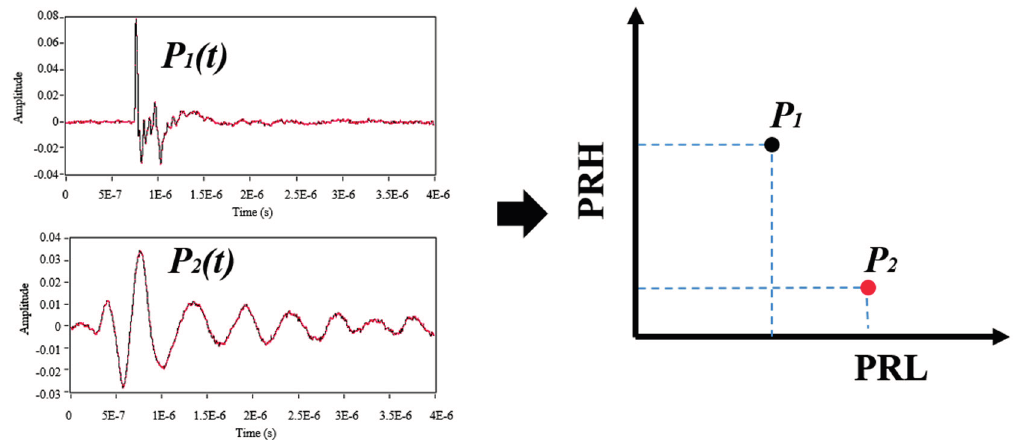
Figure 4. Example of PR map for two pulse sources (PD and